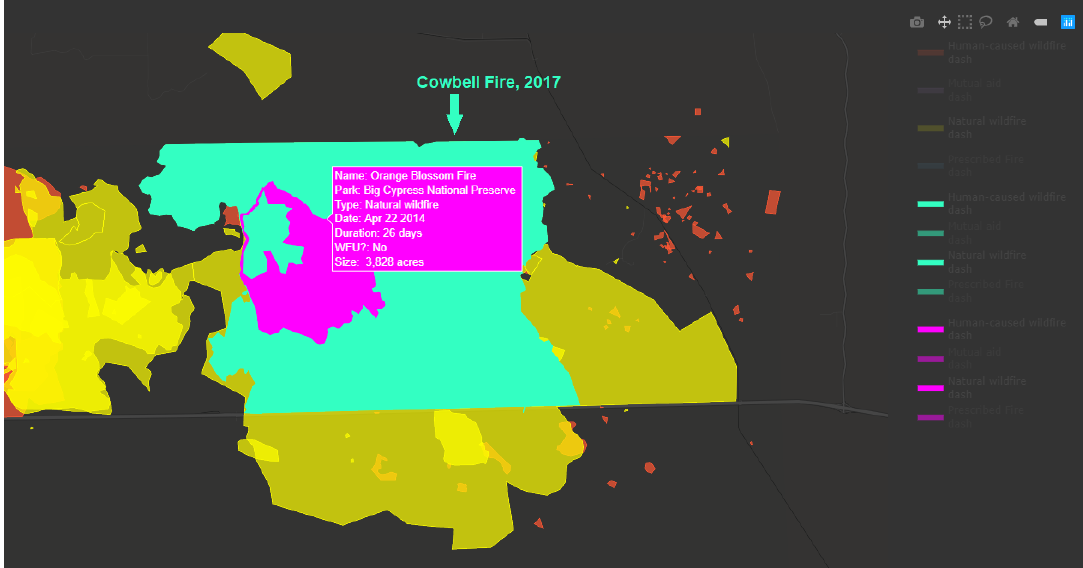
Figure 9. Fire perimeters of the 2014 Orange Blossom fire (pink) and 2017 Cowbell fire (turquoise) in Big Cypress National Preserve. These two fires, which burned some of the same area within a short fire return interval, exemplify how VISTAFiRe users can zoom, highlight and hover to visualize the details of specific fire events, which can identify avenues of future research and target field studies.